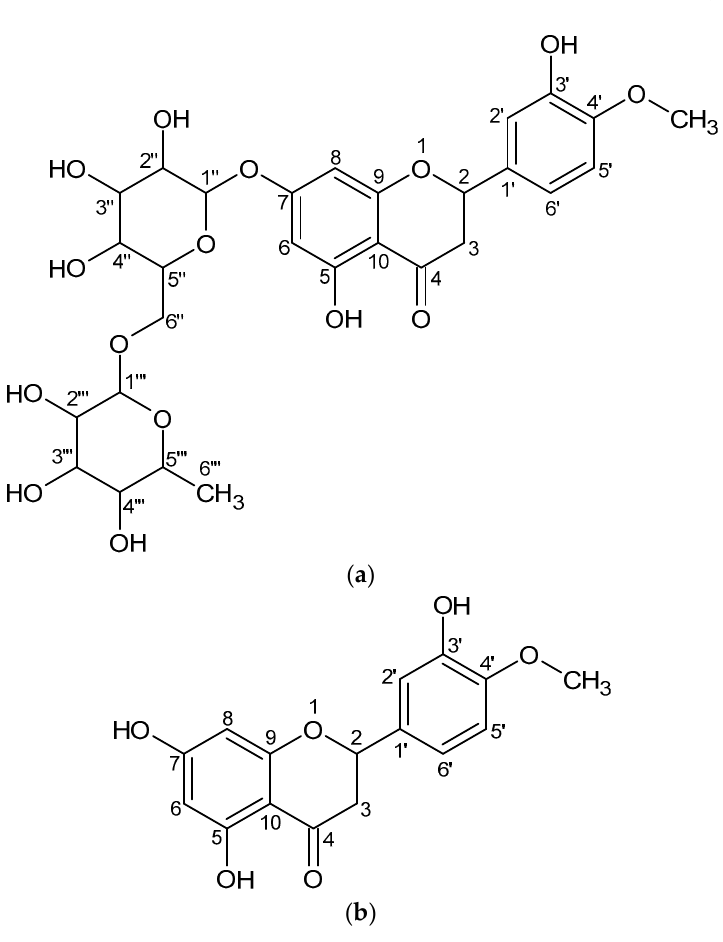
Figure 1. The chemical structures of hesperidin ( a ) and hesperetin ( b ). The structures were obtained via ACD/ChemSketch 2021.2.1.